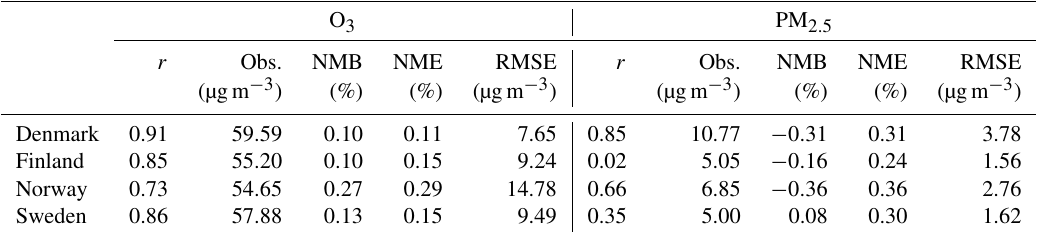
Table 4. Model evaluation for the daily mean concentrations of O 3 and PM 2 . 5 for all the selected stations in the Nordic countries. O 3 PM 2 . 5 r Obs. NMB NME